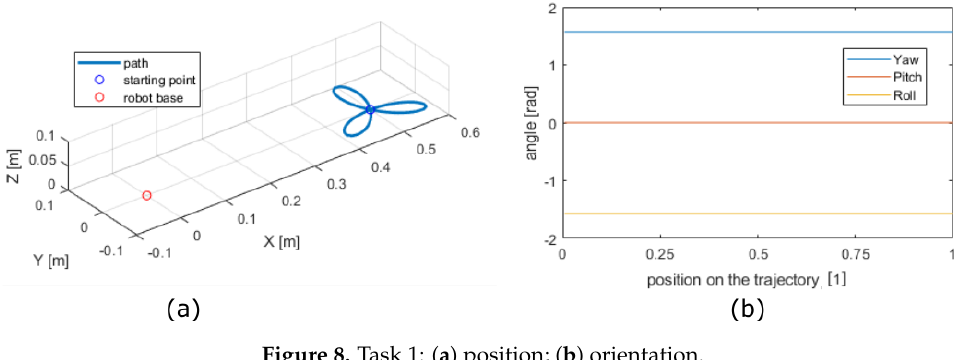
Figure 8. Task 1: ( a ) position; ( b ) orientation.